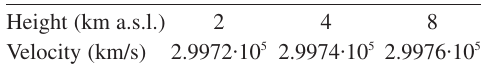
Table V. The one-dimensional a priori model for radio waves velocity with respect to height above sea level. Electromagnetic waves velocity were calculat- ed using atmospheric model discussed in the previ- ous sections, with standard values for atmospheric parameters at sea level ( t 0 = 20°C; P 0 = 1013.25 mb; H 0 =